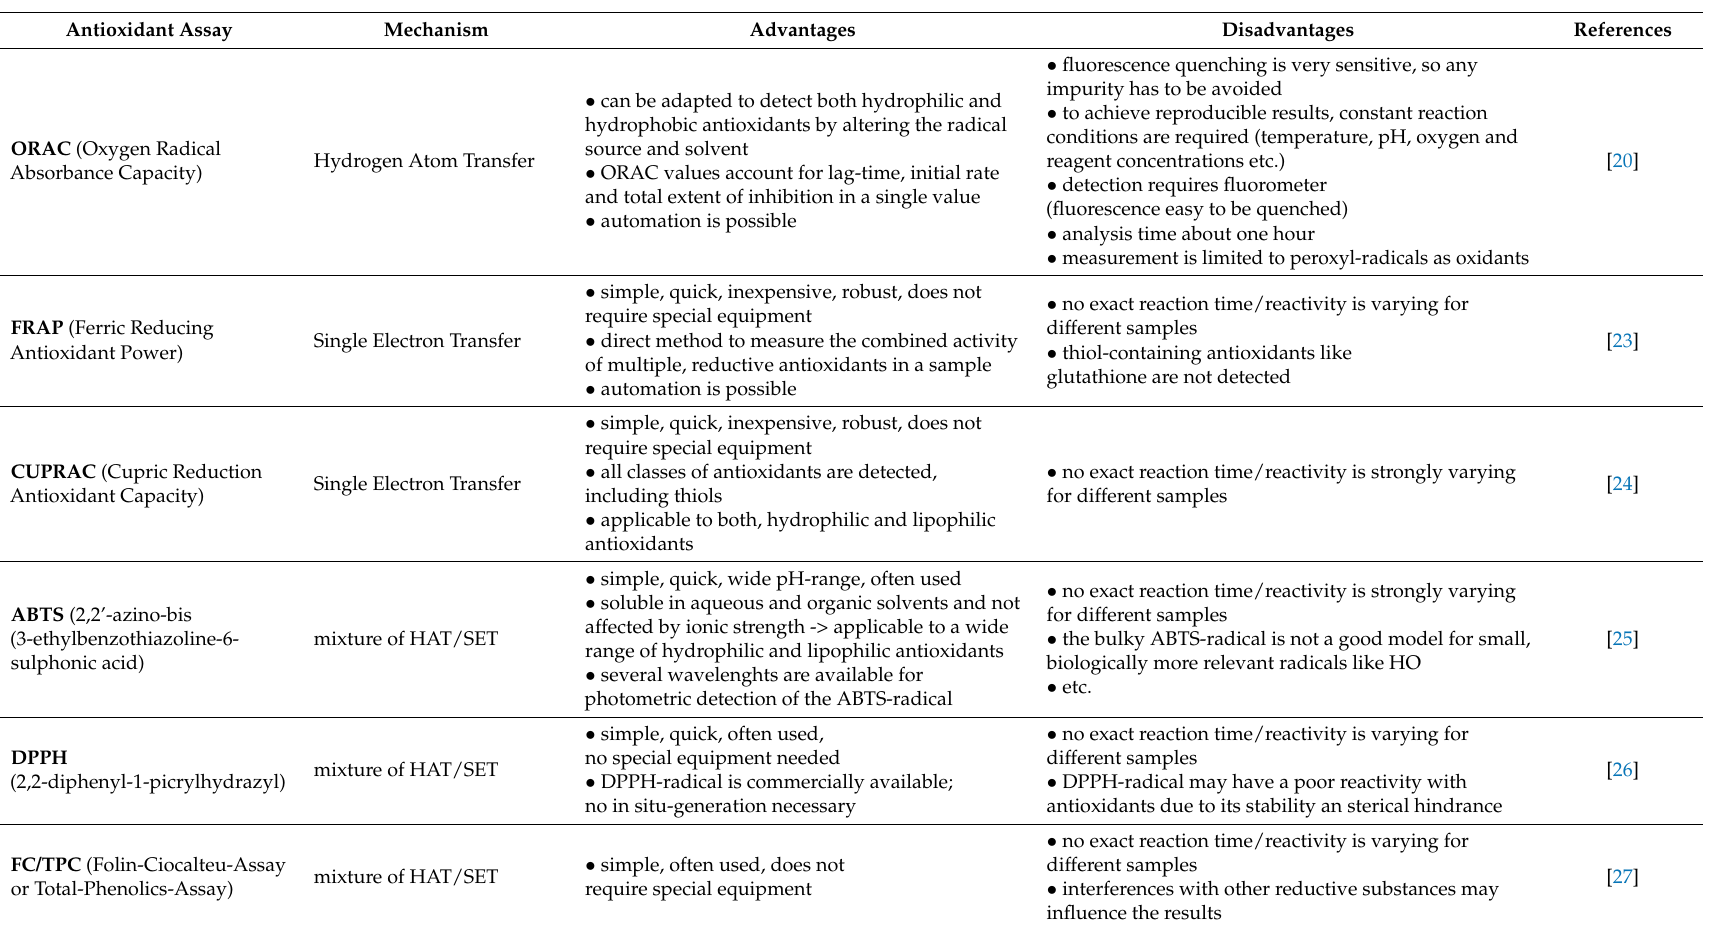
Table 1. Antioxidant assays, the corresponding reaction mechanism, advantages and